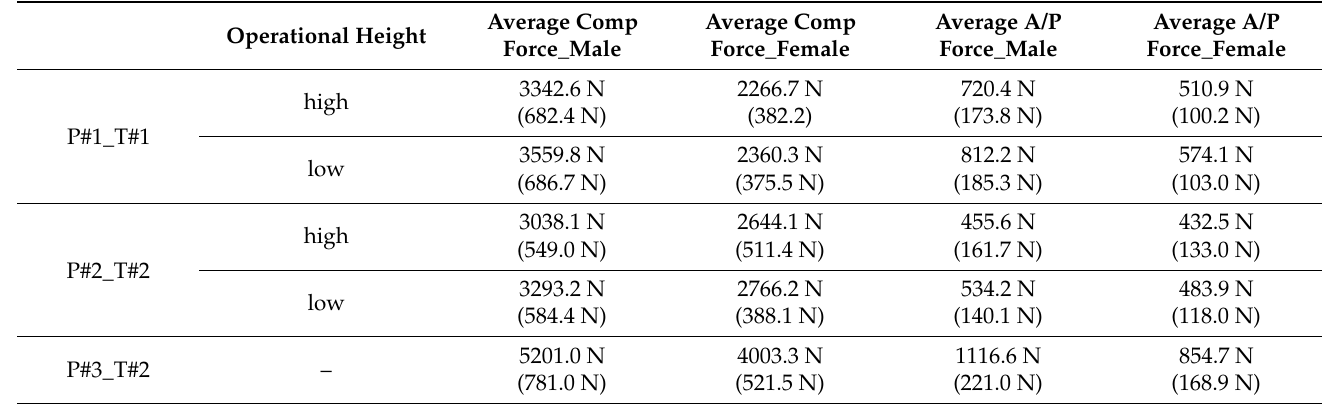
Table 2. The estimated spinal forces at each of the specific postures. The results are presented as the mean value (standard deviation).